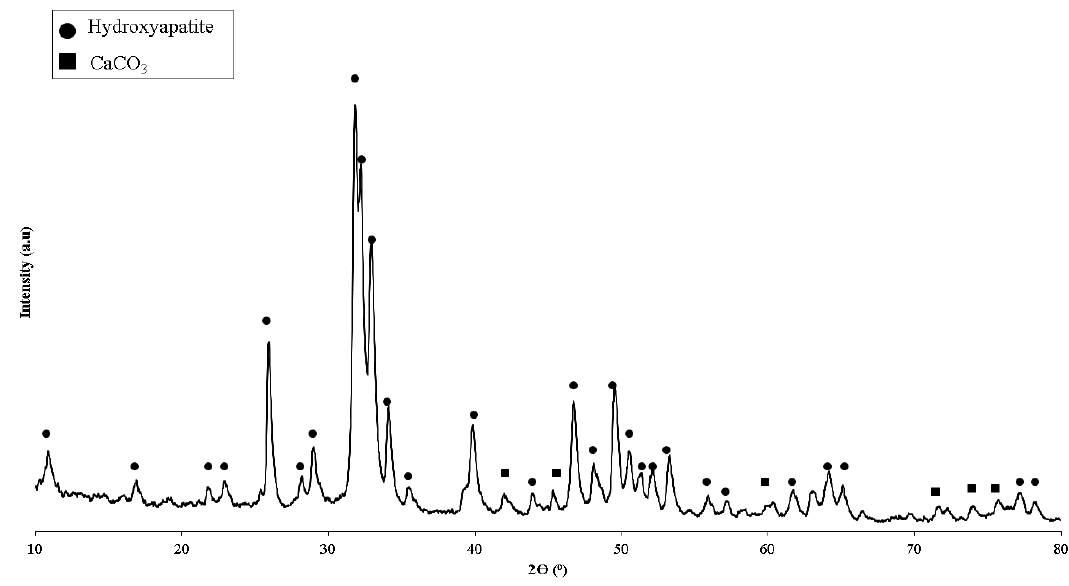
Figure 1. XRD diffraction on the hydroxyapatite of green mussel shells [32].